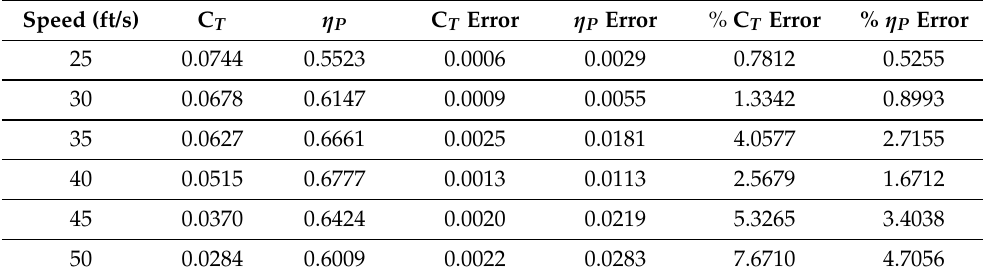
Table 5. Thrust and propeller efficiency error at 3500 RPM for an 18 × 10 APC